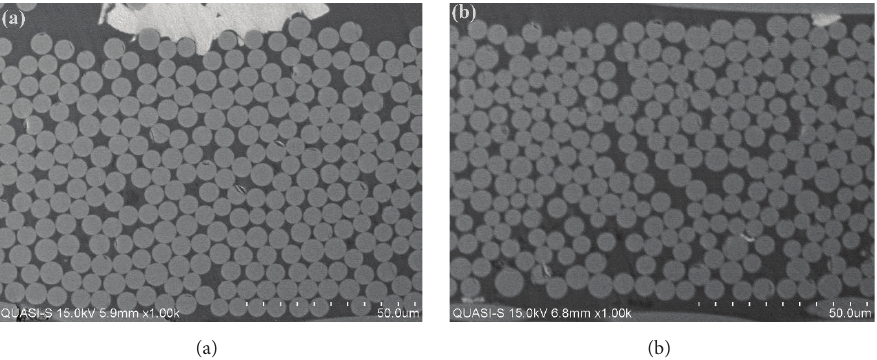
Figure 15: SEM micrographs of fiber ends at the cross-sectional area of unaged (a) and aged (b) sample.